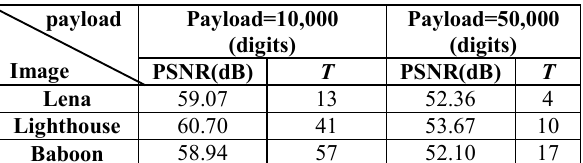
Table 1. Comparison result of PSNR and T.